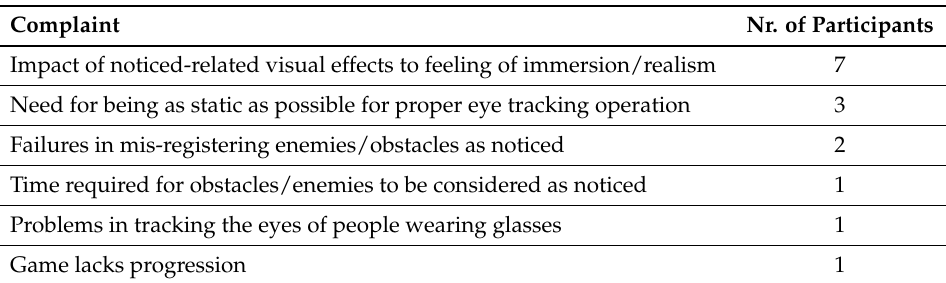
Table 4. Number of participants agreeing with a given complaint.